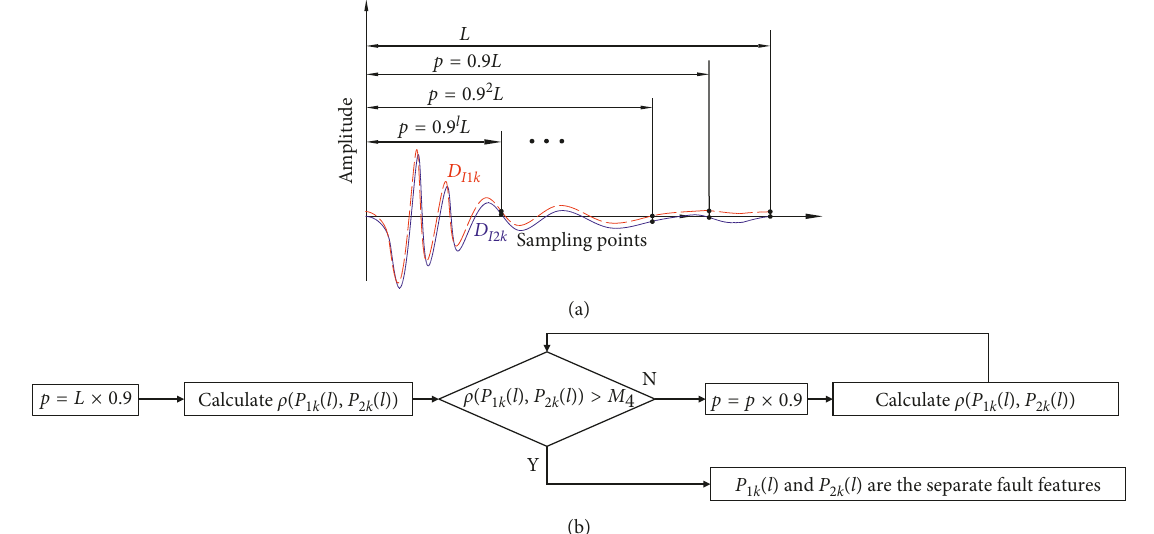
Figure 11: Method for separating fault components. (a) The principle of fault component separation. (b) The flow chart for fault component separation. p is decreased to improve the correlation between P areas. When ρ ( P 1 k ( l ), P 1 k ( l )) is greater than threshold M 4 , the P areas can be regarded as fault